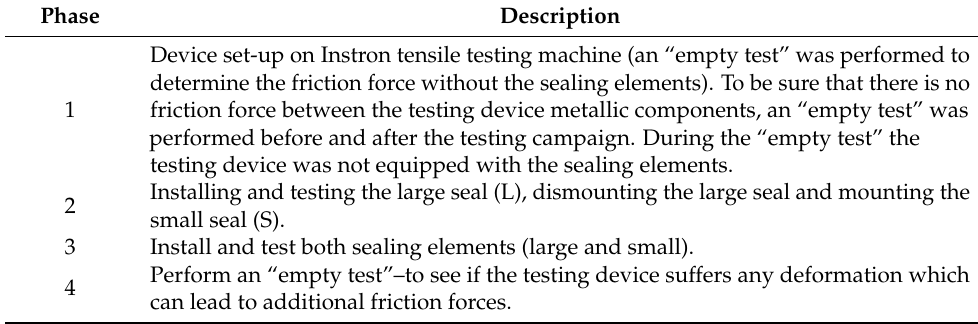
Table 3. Testing phases for sealing force